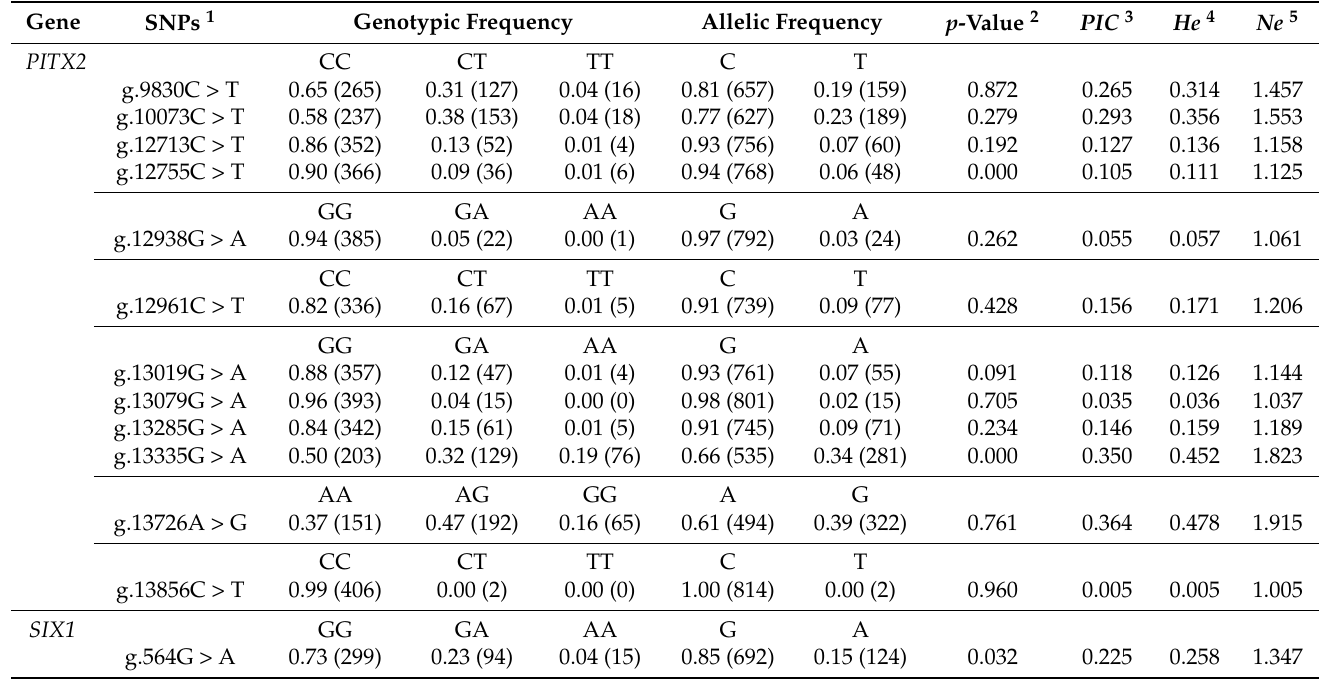
Table 2. Genotype frequency, allele frequency, and diversity parameter in the PITX2 and SIX1 genes in Wuliang Mountain Black-bone